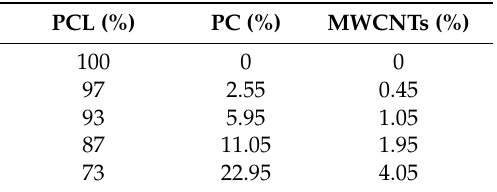
Table 1. Weight percentages of the components in the